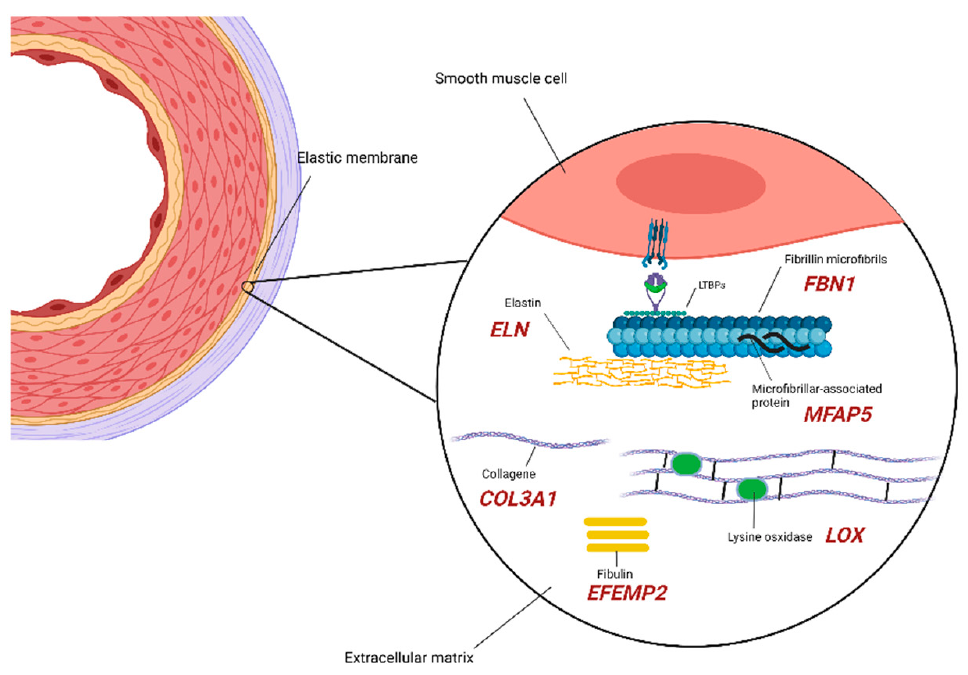
Figure 1. Schematization of the ECM main components. Genes codifying each component are reported in red (created with BioRender.com (accessed on 13 May 2022)).